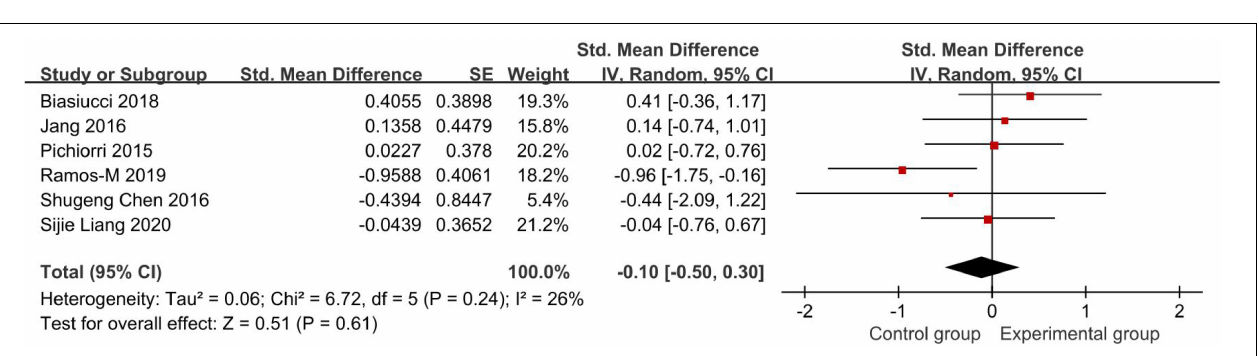
FIGURE 6 | Forest plot of the Modified Barthel Index (MBI) score to evaluate the effect of BCI on upper limb dysfunction after stroke.